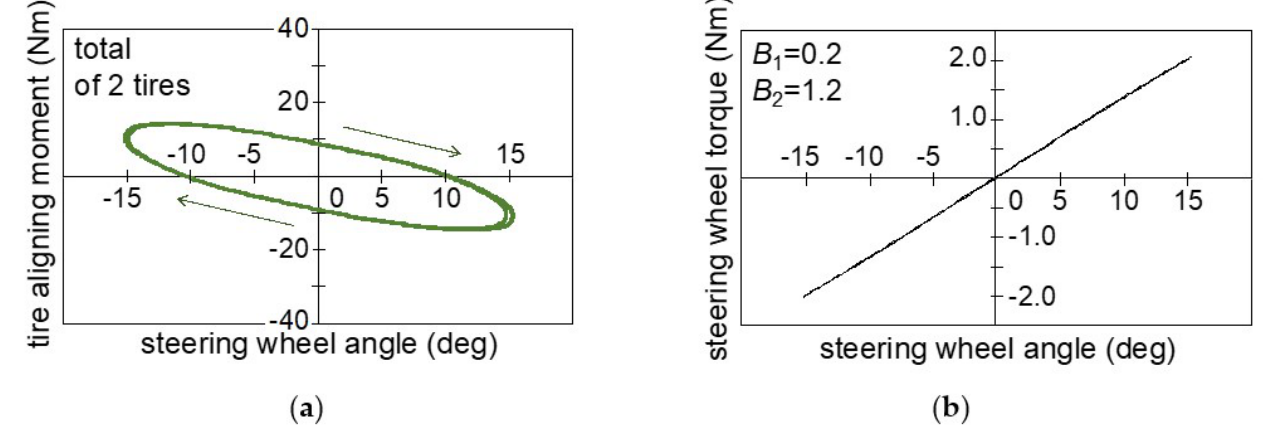
Figure 5. ( a ) Original tire aligning moment. ( b ) Adjusted steering wheel